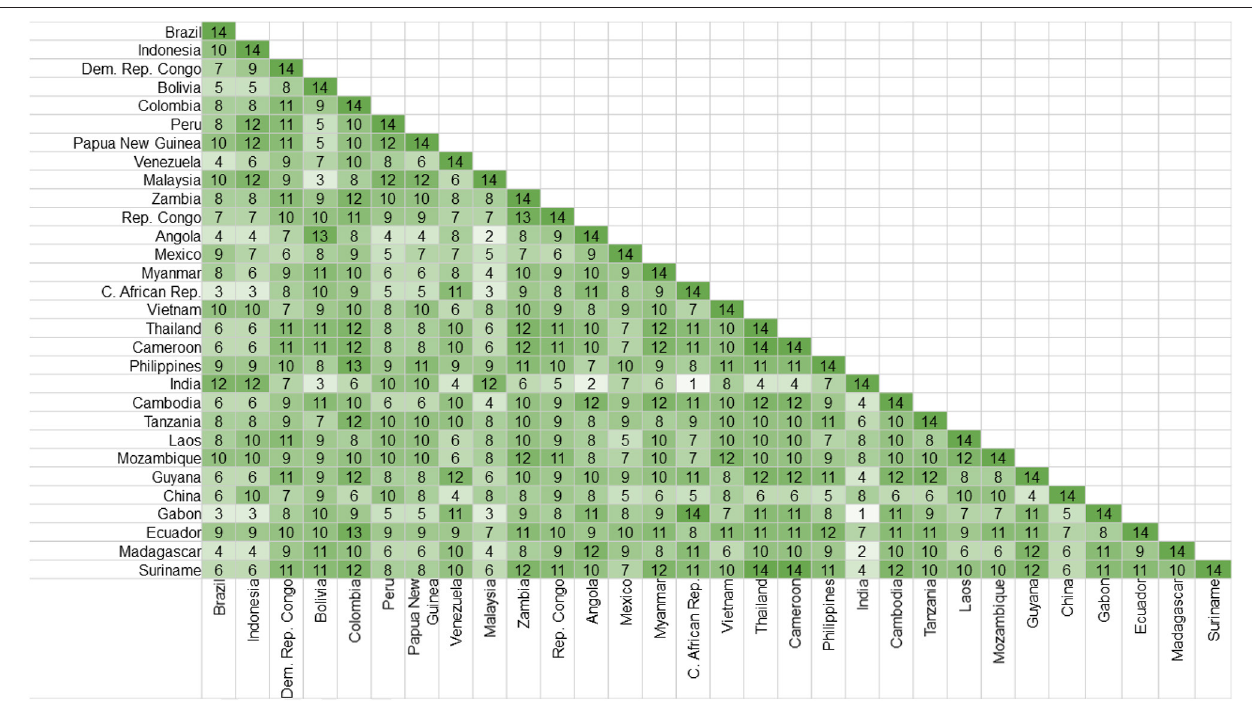
FIGURE 2 | Number of authorities (out of 14) with the same score in both countries, for each pair of